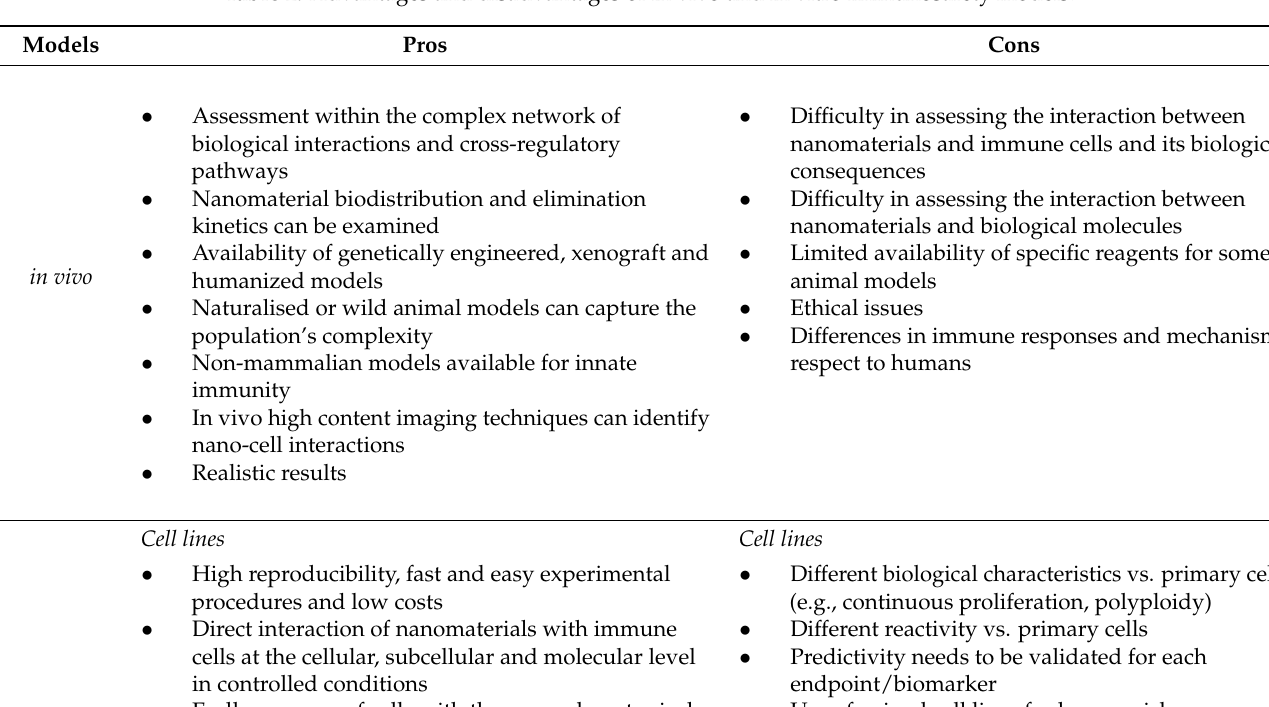
Table 2. Advantages and disadvantages of in vivo and in vitro immunosafety